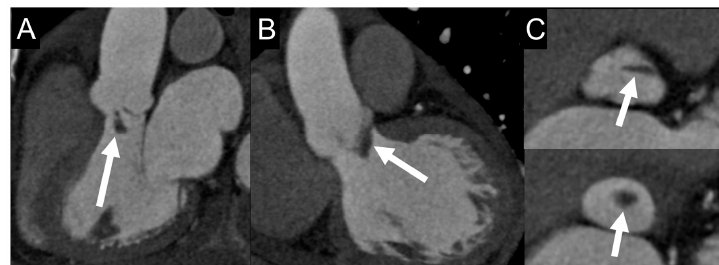
Figure 3. Vegetation on cardiac computed tomography angiography (CCTA) images. A 69-year-old man with fever and IE. Multiplanar CCTA reconstructions on three-chamber ( A ) and coronal ( B ) views show a 2-cm, hypodense, club-shaped, soft-tissue oscillating mass (arrows) attached to the ventricular side of aortic valve leaflets, which appear floating in the lumen of the left ventricular outflow tract in reconstructed axial valve planes ( C ). Sensitivity of CCTA in detecting vegetation ranges from 52.8% for small lesion to 94.4% for larger ones ( > 10 mm)